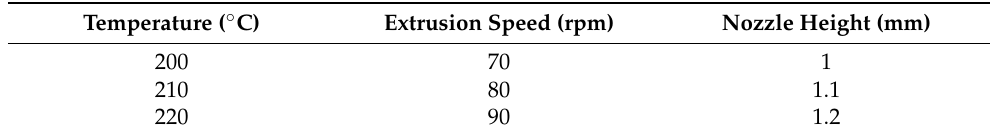
Table 8. Printing process parameters.